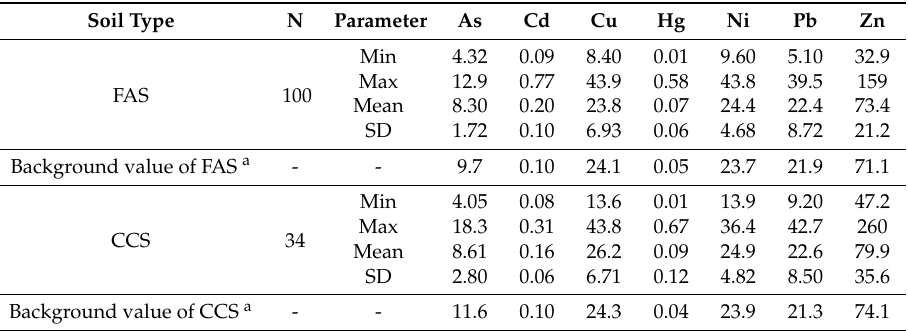
Table 4. Metal concentrations in different soil types in the agricultural